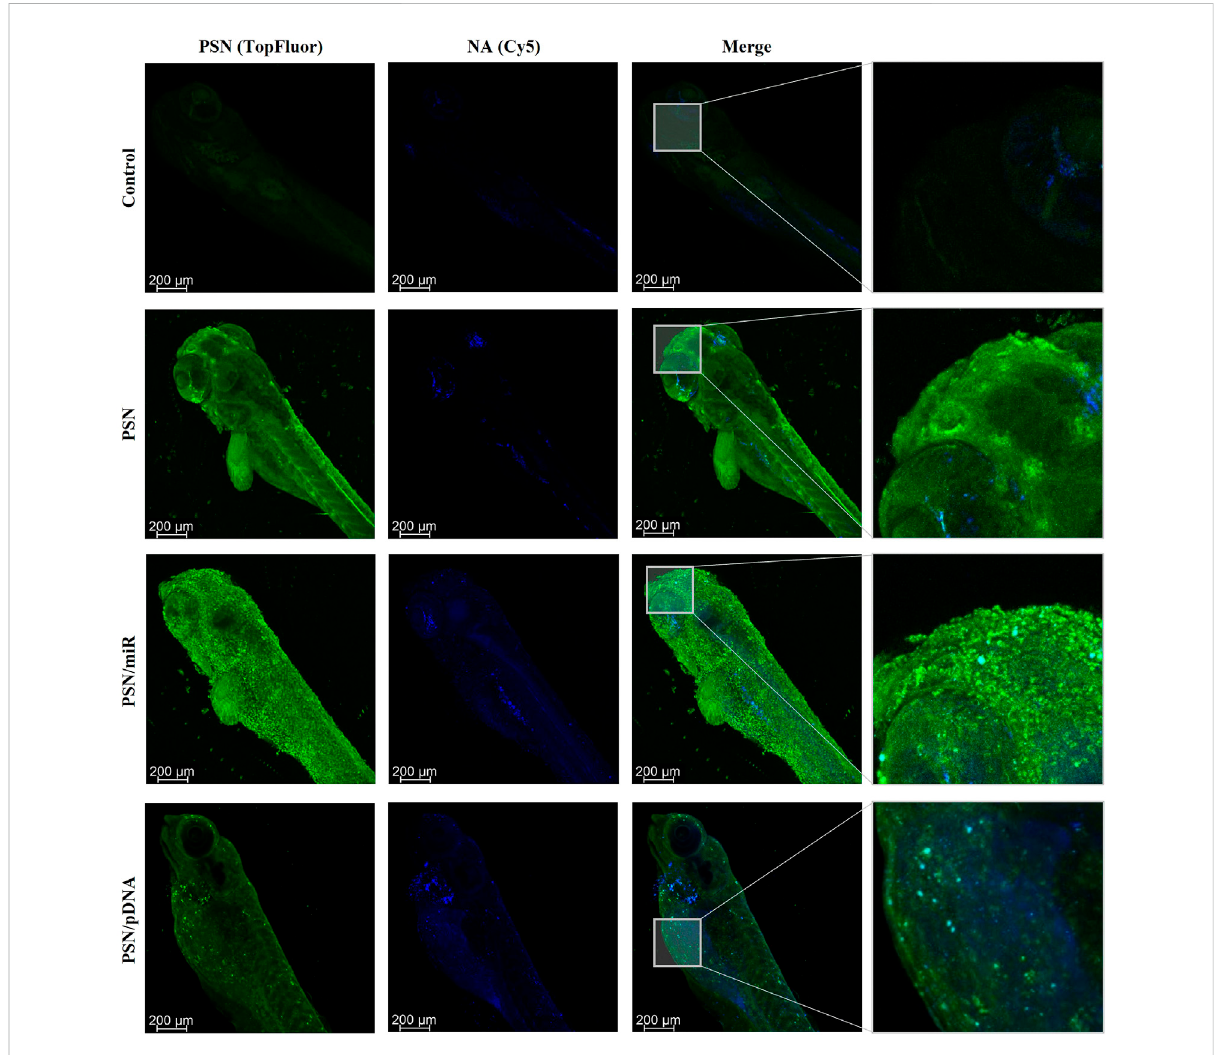
FIGURE 3 Confocal images of zebra fi sh embryos after a 72 h incubation with TopFluor-PSN (in green) associated and non-associated with Cy5-labelled miR and pDNA (in